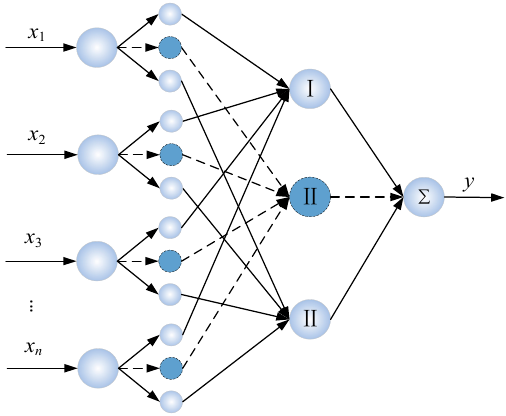
Figure 6. The structure of neural networks.